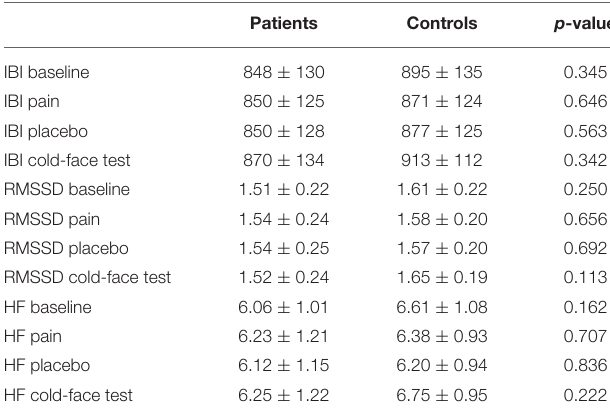
TABLE 4 | HRV parameters in patients and controls at T1 (reported as mean ± SD; results of t -tests).